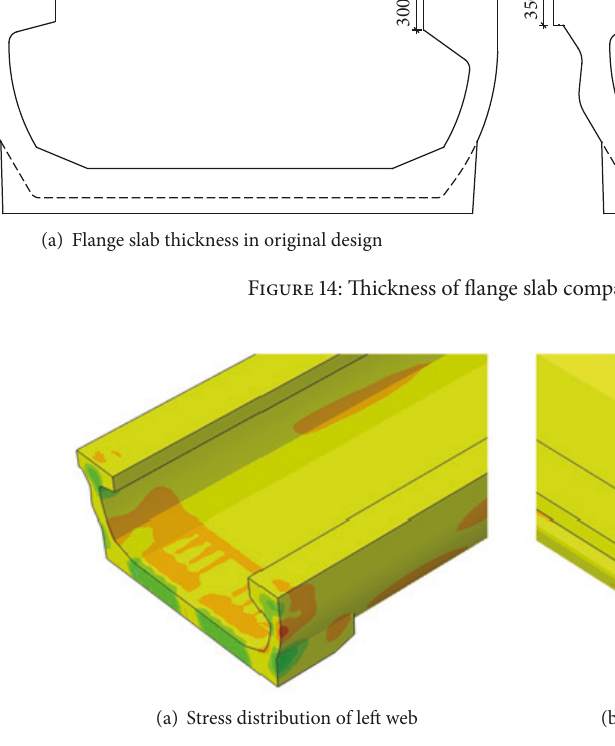
Figure 15: Stress contours at the end of U-shaped girder after tensioning with Parameter 1.